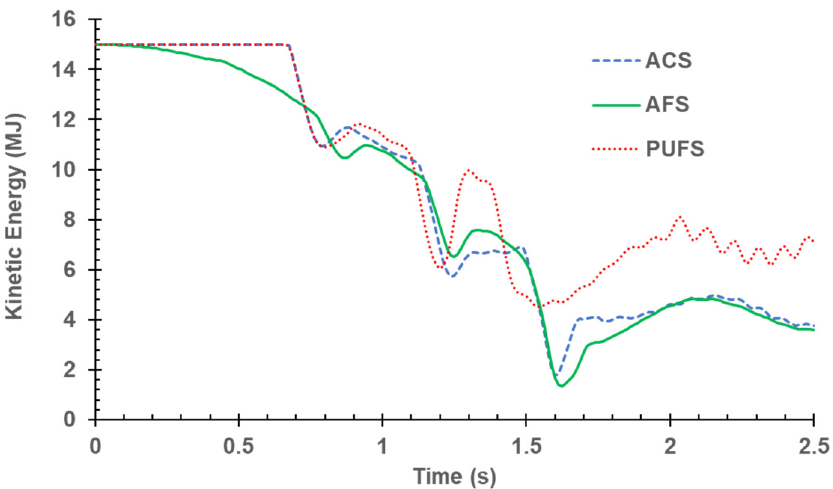
Figure 17. Kinetic energy-time curves.